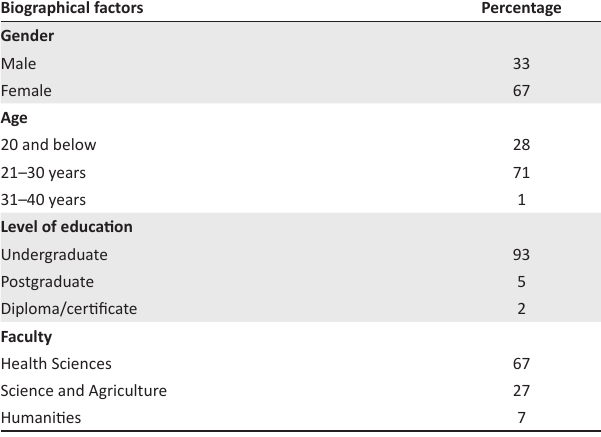
TABLE 1: Biographical details of the